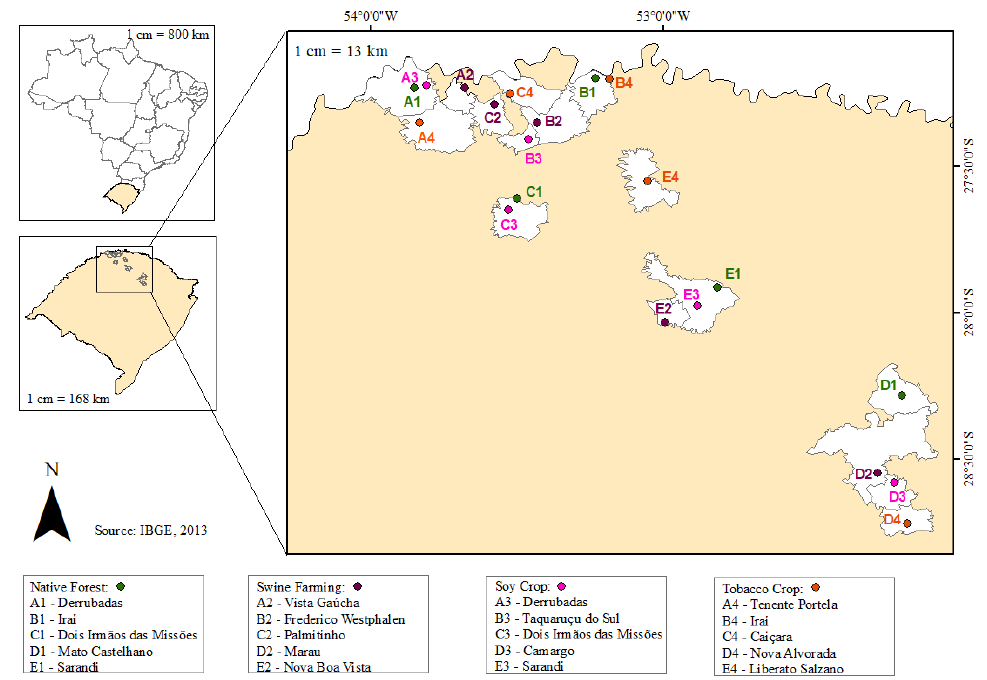
Figure 1. Location of the springs evaluated in each land use and occupation condition (1: native forest; 2: swine farming; 3: soy crop; and 4: tobacco crop). The cities are described in A1 to E4 [15].